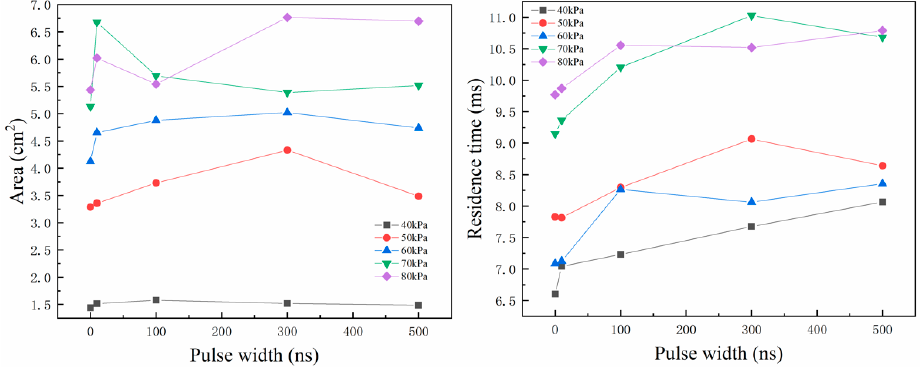
Figure 20. Low-velocity-region areas ( left ) and fuel-air-mixture residence times ( right ) for different pressures and pulse widths.